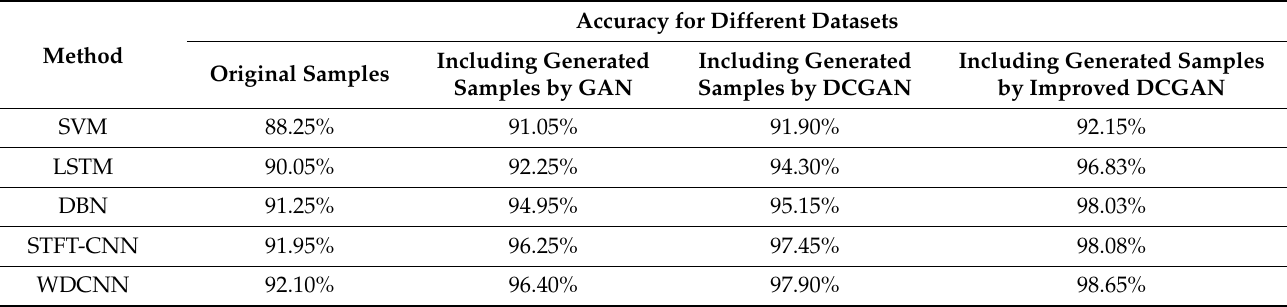
Table 6. Comparison of different diagnostic methods for different